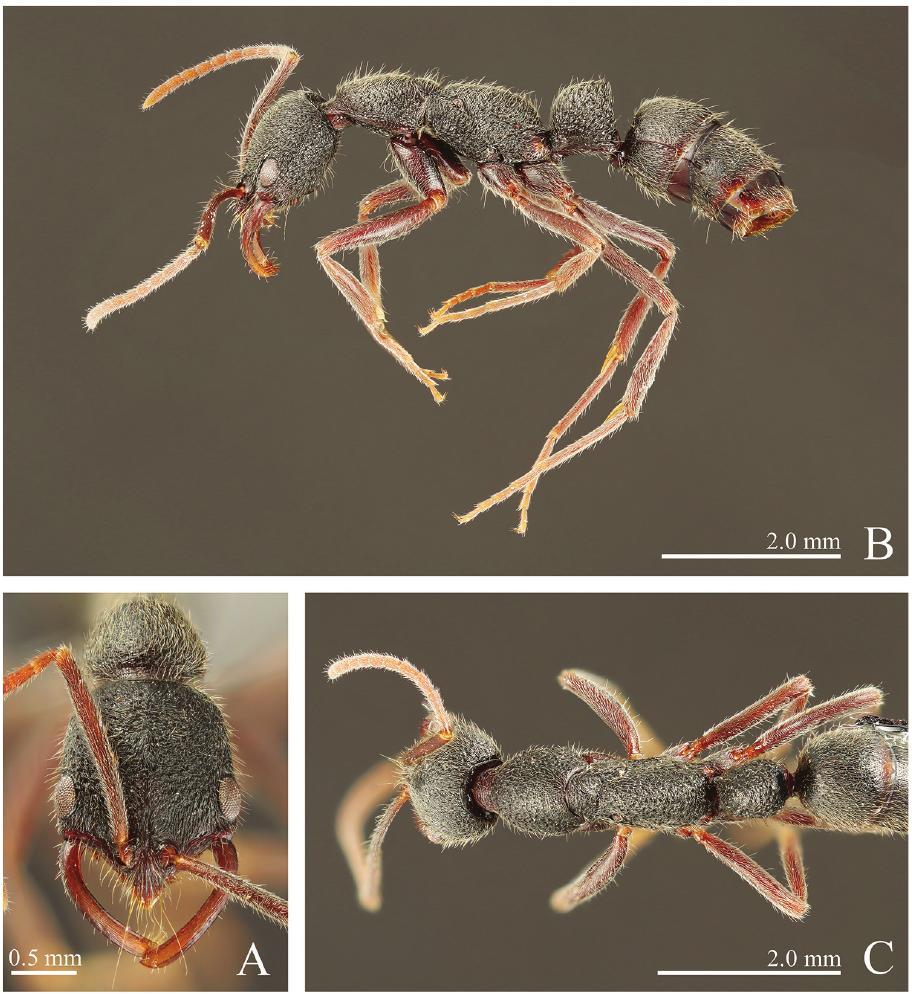
Figure 6. Leptogenys curva sp. n., holotype, worker; gastral apical two segments removed. A head, full- face view B lateral view C dorsal